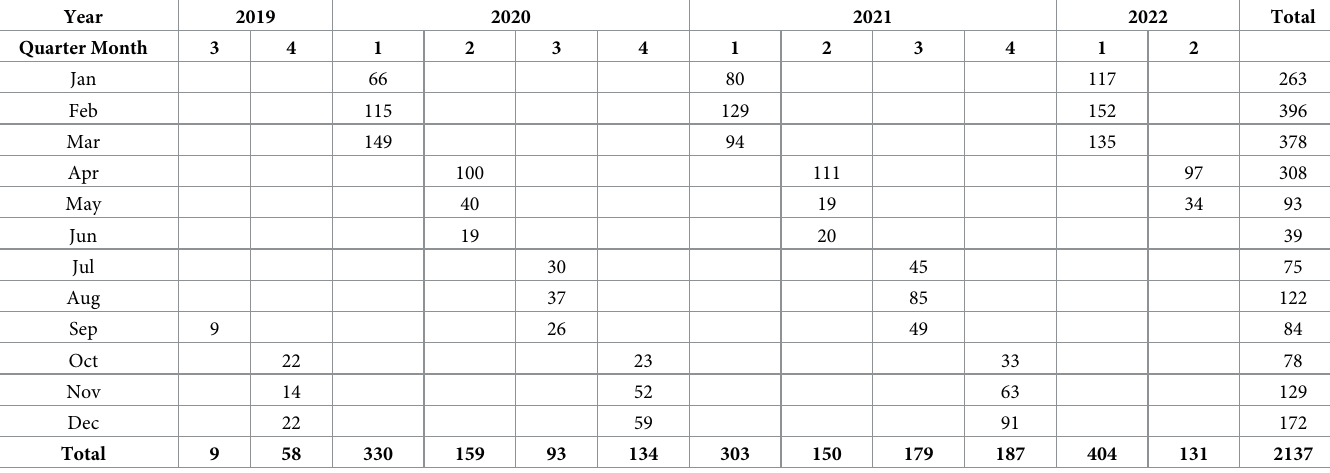
Table 1. ASFV outbreak locations in South Korea during different time periods with quartile